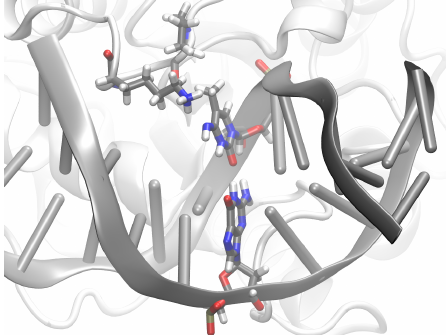
Figure 13. Snapshot of IMC imino methyl-cytosine in complex with TDG. Protein and DNA are represented as cartoon, the G:XC pair is shown in licorice and protein residues K201 and P202 are also shown in